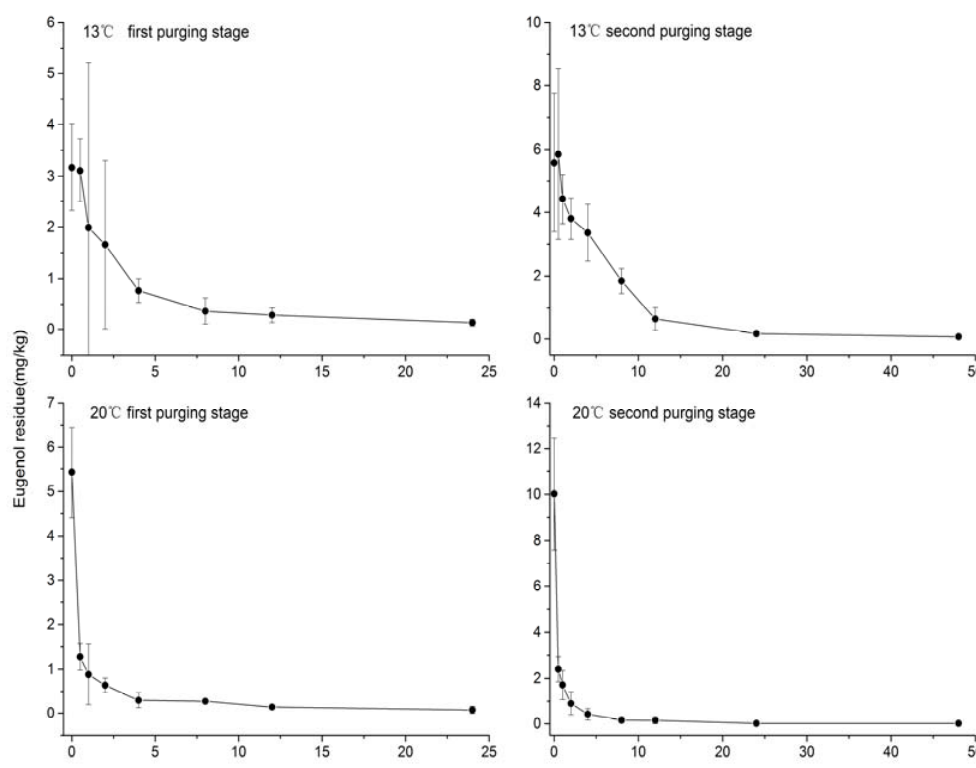
Figure 1. Eugenol residue in fillet of sea basses depending on the purging time.